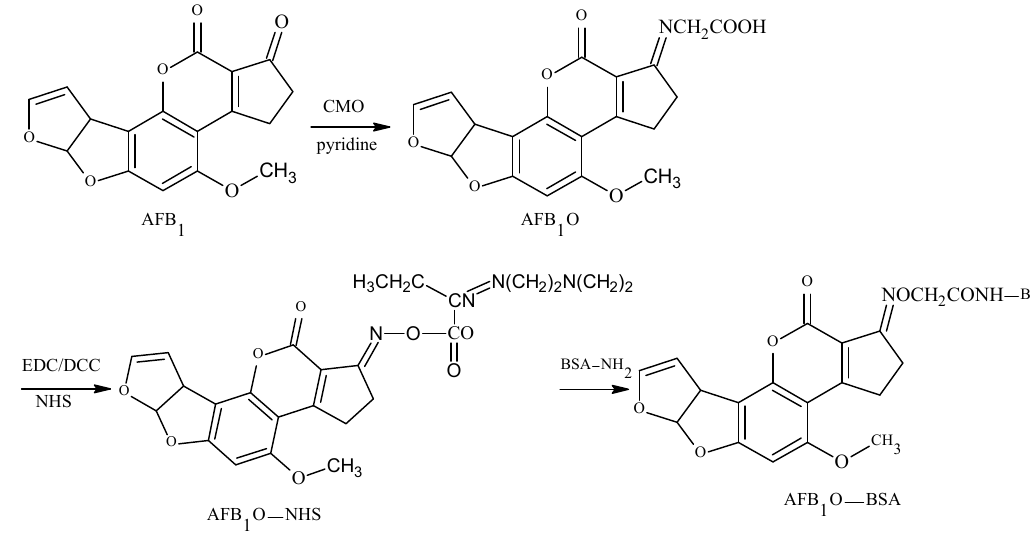
Figure 2. Synthesis of the AFB1-BSA antigen by the oxime active ester (OAE) method.